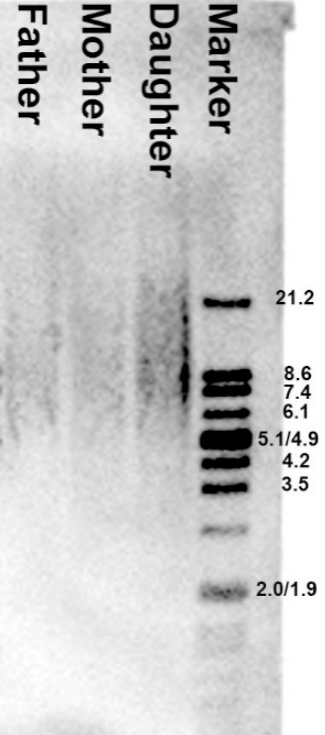
Figure 5. Differences in leukocyte telomere length between parents and child. The mean telomere restriction fragment (TRF) length was measured by Southern blot analysis. Marker—molecular weight marker (kb). The mean TRF length for each sample was provided in kb on the basis of the signal intensity peak from the TRF as a result of multiple hybridization of telomeric-specific hybridization probes. Father ≈ 8.6 kb, mother ≈ 9.0 kb, daughter ≈ 9.3 kb.